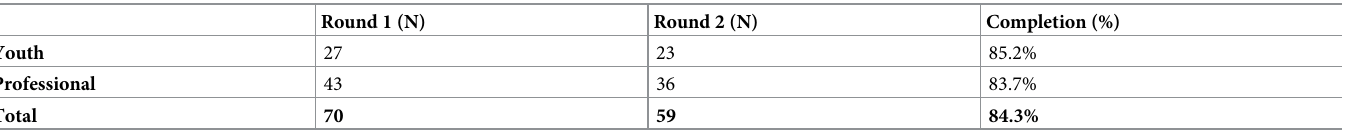
Table 2. Participation rates of panel